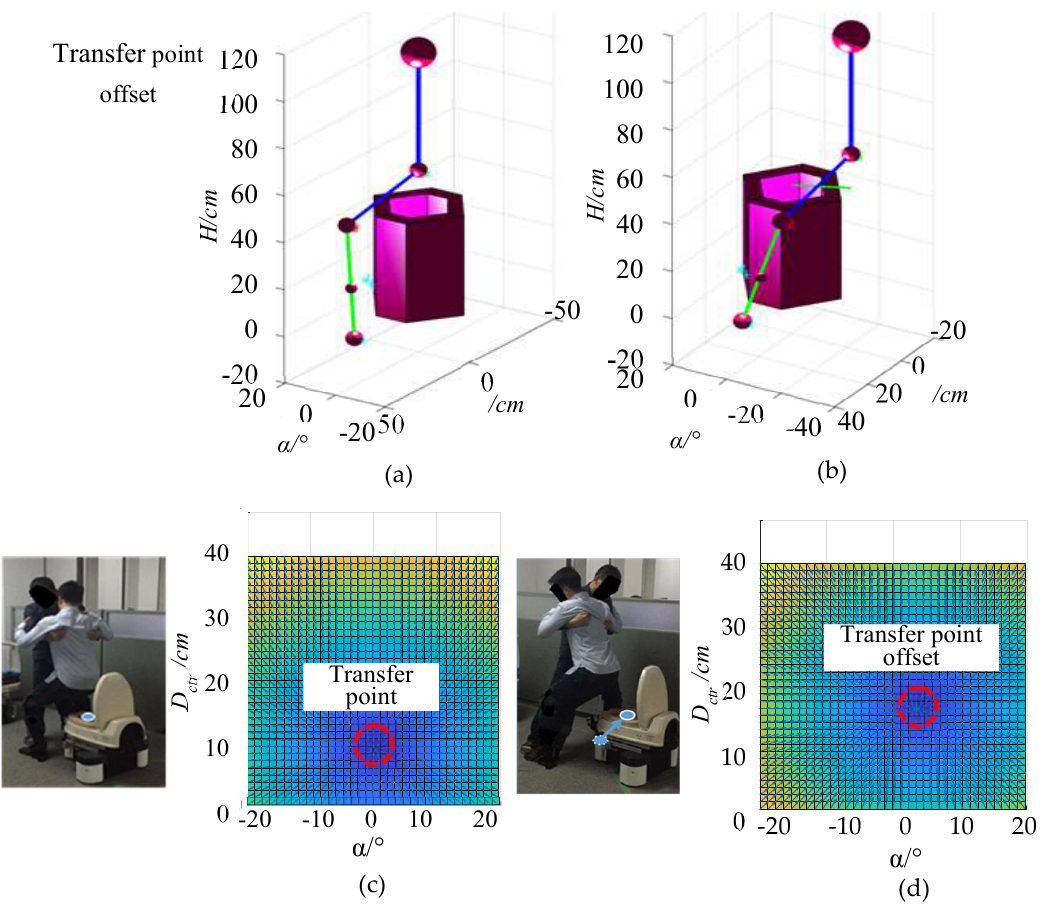
Figure 14. Robot-following experiment based on the analysis of transfer position and posture.